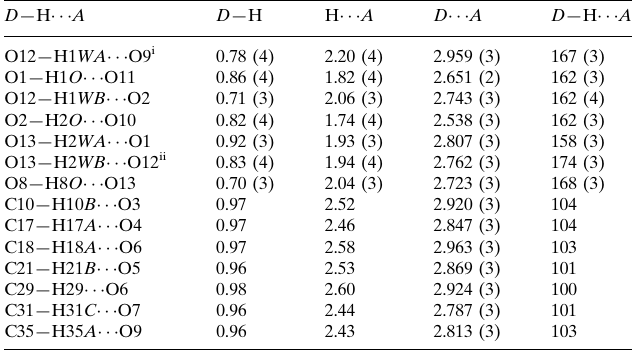
Hydrogen-bond geometry (A˚ , (cid:4)